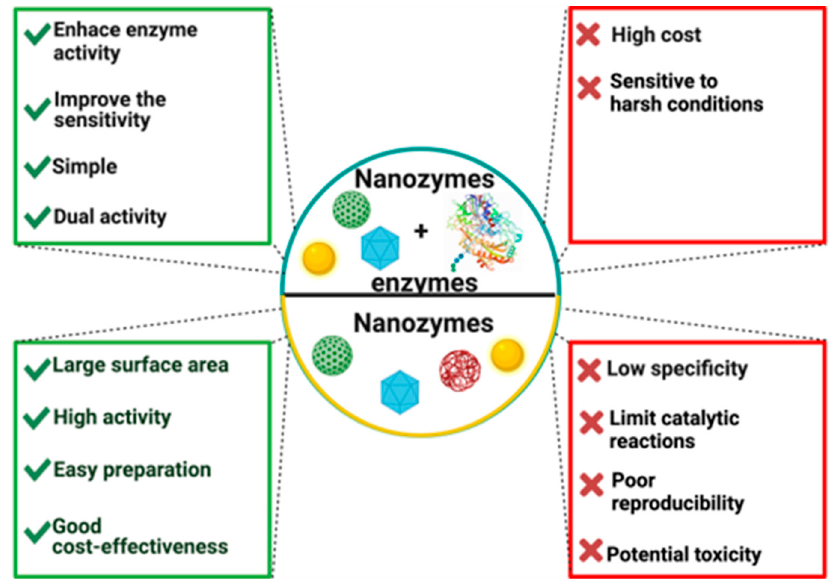
Figure 6. Advantages and disadvantages of nanozymes and nanozymes-enzymes pool. Table 7. Nanozyme-enzyme pool in biosensors.